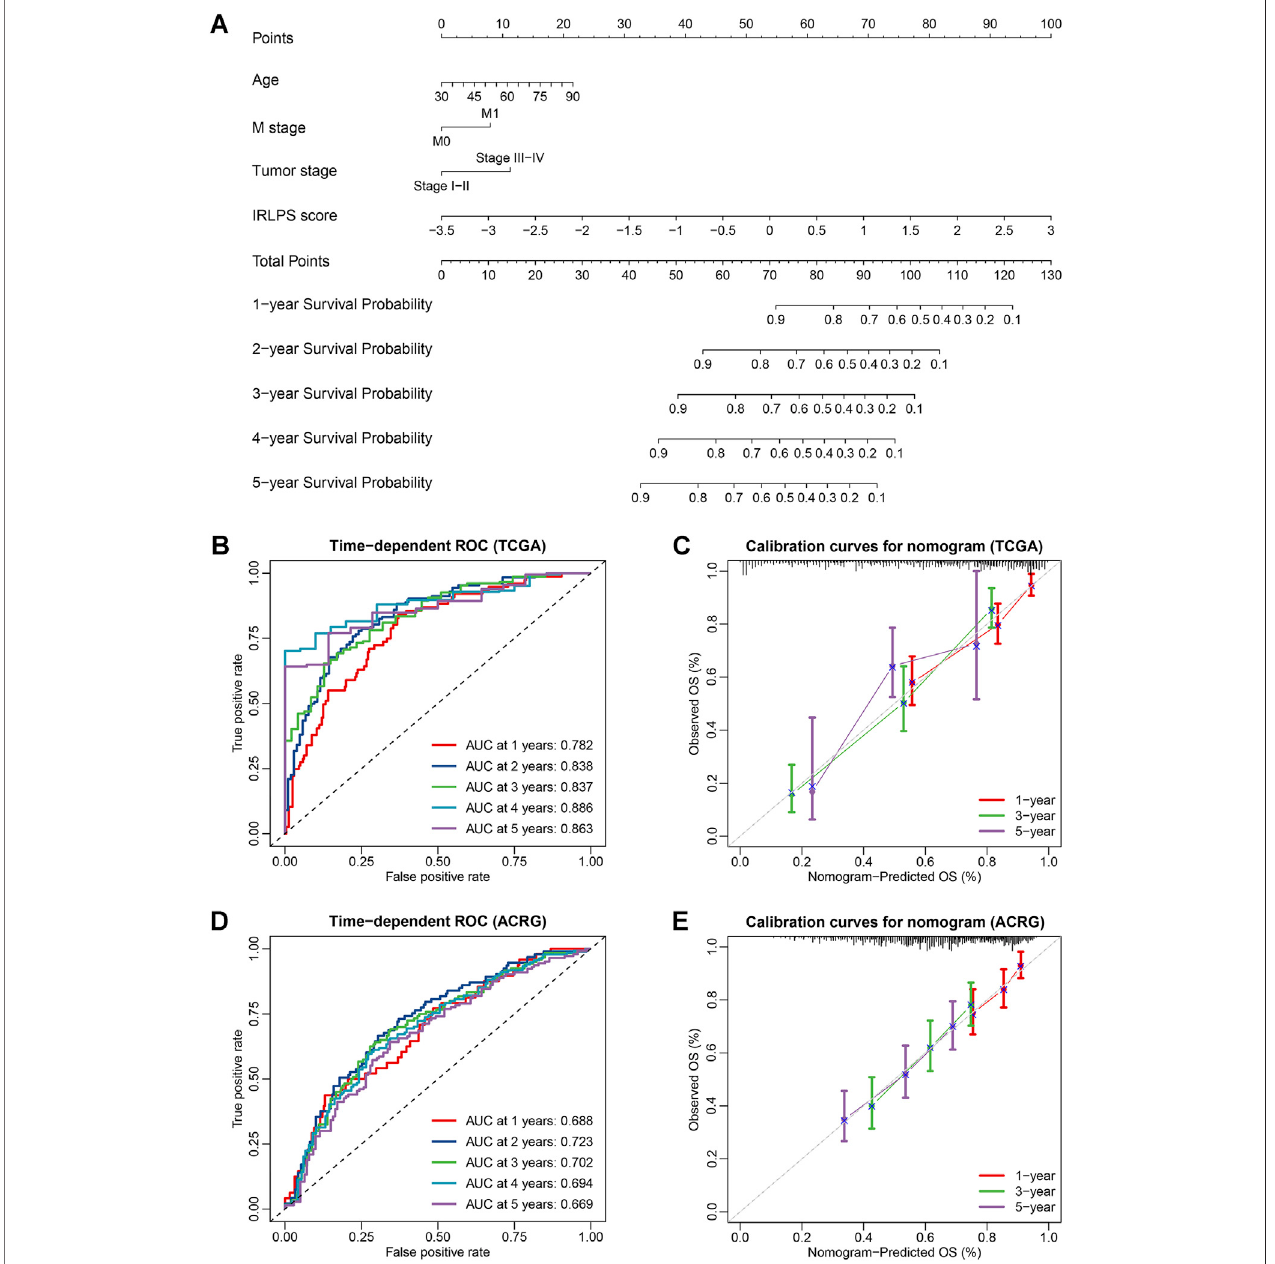
FIGURE 8 | Construction and validation of an individualized nomogram for the overall survival (OS) prediction based on independent prognostic factors. (A) A nomogramforthepredictionofOSintegratingourprognosticsignaturewithindependentclinicalvariables(age,Mstage,andtumorstage)wasconstructedintheTCGA cohort; (B,D) Time-dependentreceiveroperatorcharacteristic(ROC)curvesforOSpredictionofthenomogramintheTCGAandAsianCancerResearchGroup(ACRG) cohorts; (C,E) Calibration curves of the nomogram on 1-, 3-, and 5-years survival probability in the TCGA and ACRG cohorts.